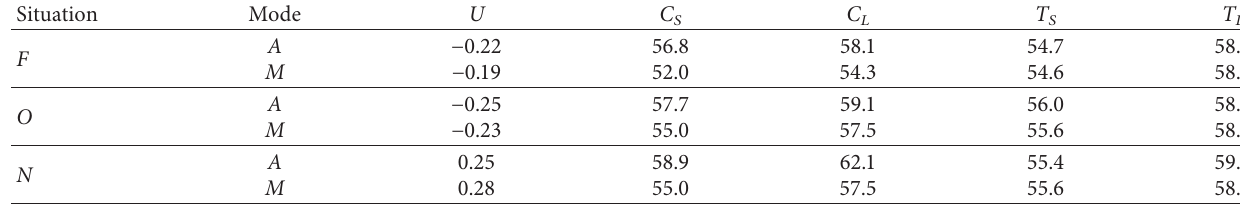
Table 11: Transportation plans with different transportation modes.